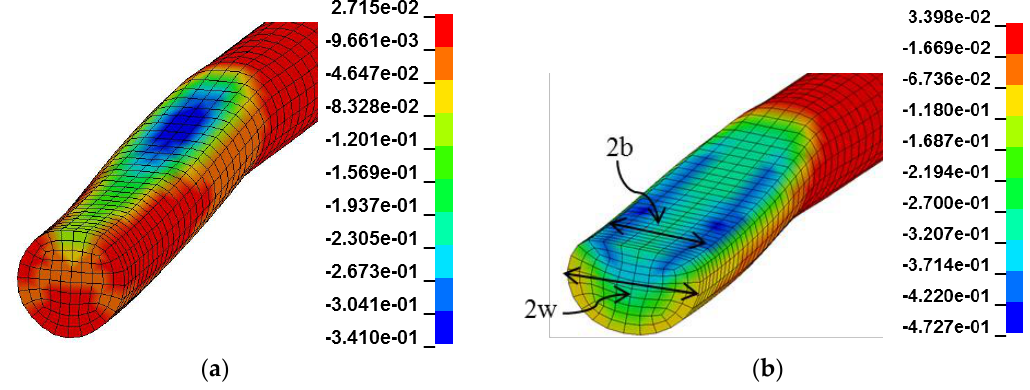
Figure 5. Contours of transverse compressive strains at a 200 m/s impact at 0.03 µ s; ( a ) elastic; and ( b ) inelastic.